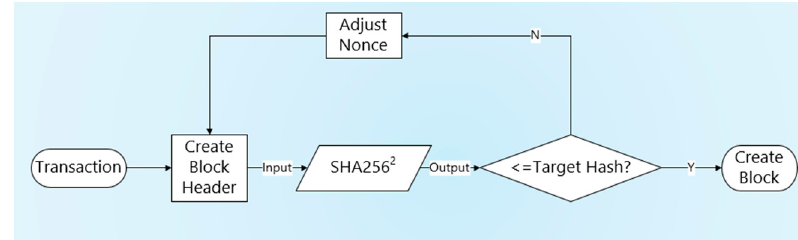
Figure 1. Bitcoin block structure.